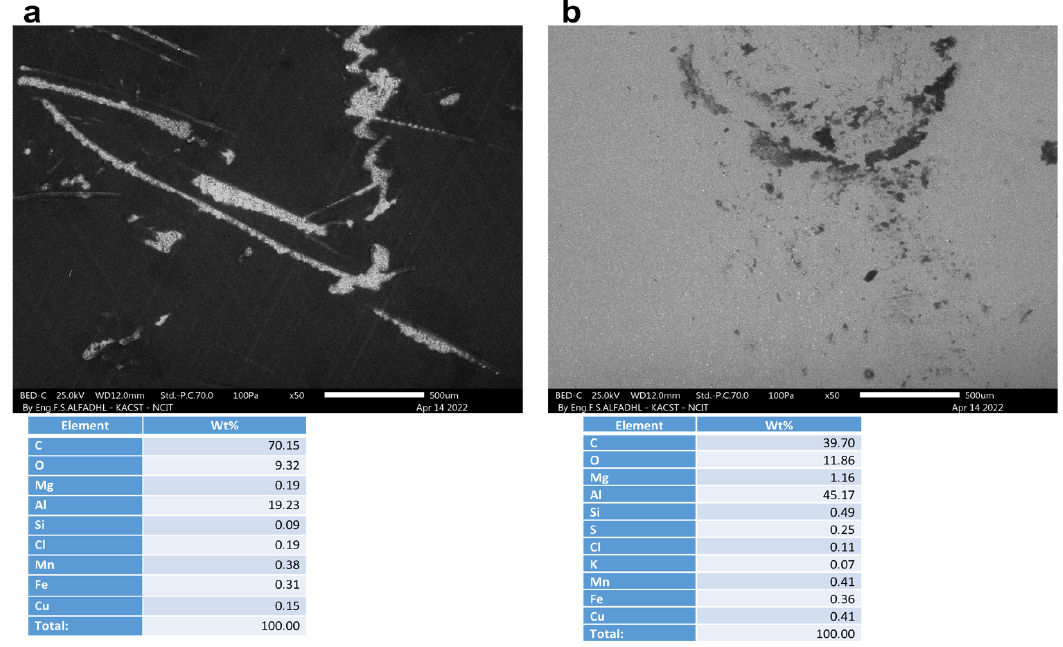
Figure 10. SEM and EDS analysis of Green Cola samples after corrosion tests under different conditions: ( a ) main solution in the presence of an organic coating (WC) and ( b ) without an organic coating (WOC).